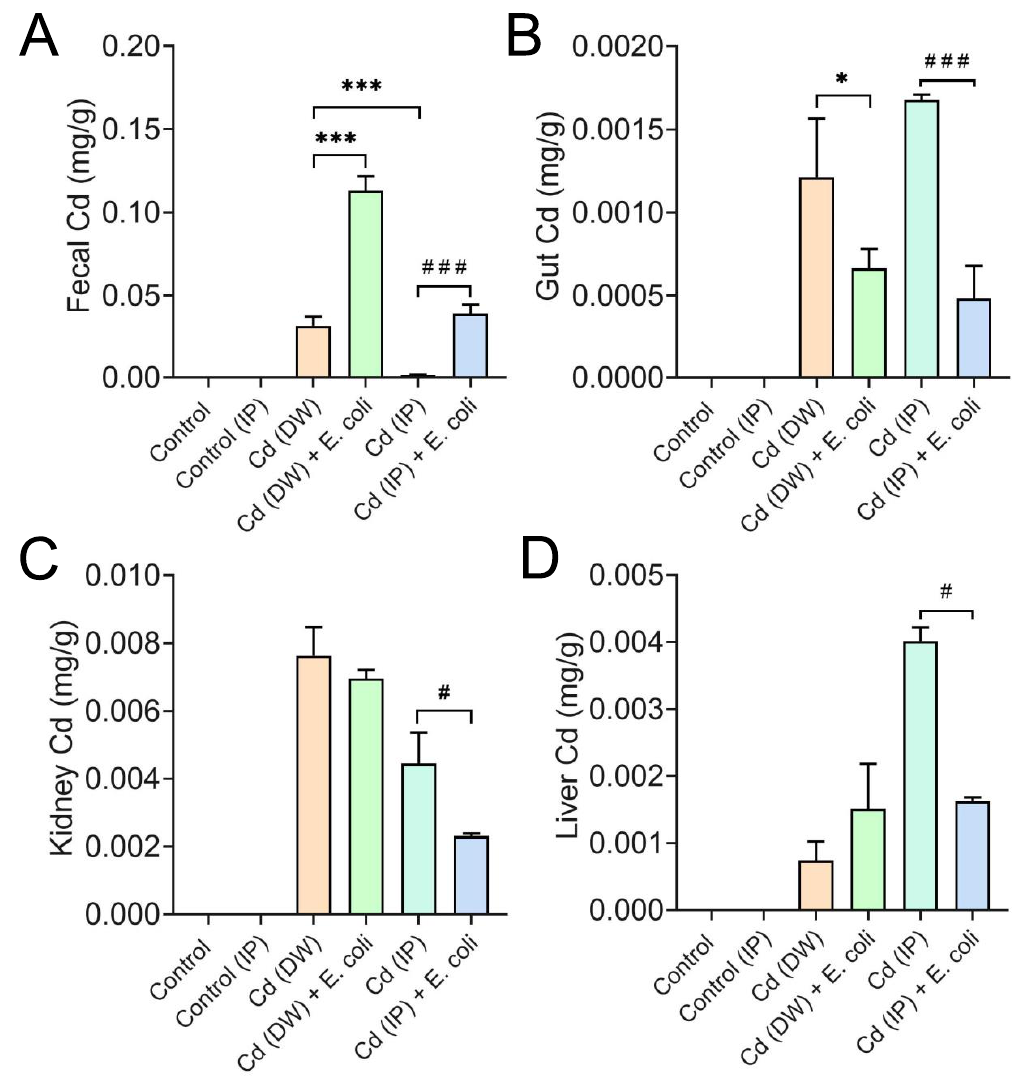
Figure 6. The Contents Cd in feces ( A ), gut ( B ), kidney ( C ), and liver ( D ). * p < 0.05, *** p < 0.001 indicate results that differ significantly from Cd (DW). # p < 0.05, ### p < 0.001 indicate results that differ significantly from Cd (IP). E. coli represented HLA-1-1 in this figure.